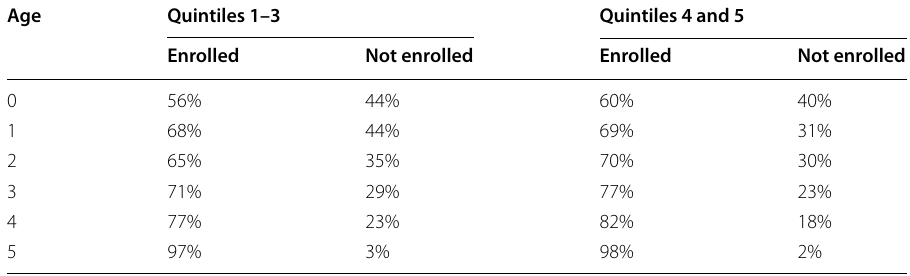
Table 11 Average percentage of children enrolled in ECD programs